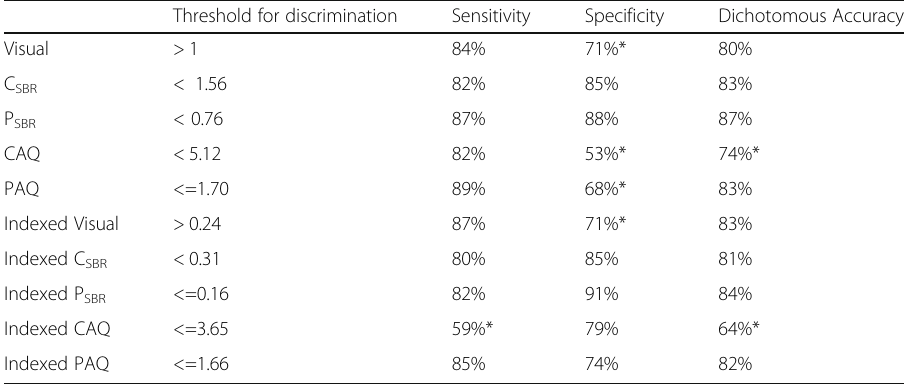
Table 3 ROC result for discriminating patients with ET from those with all other disease states (i.e., PD, MA and DLB)